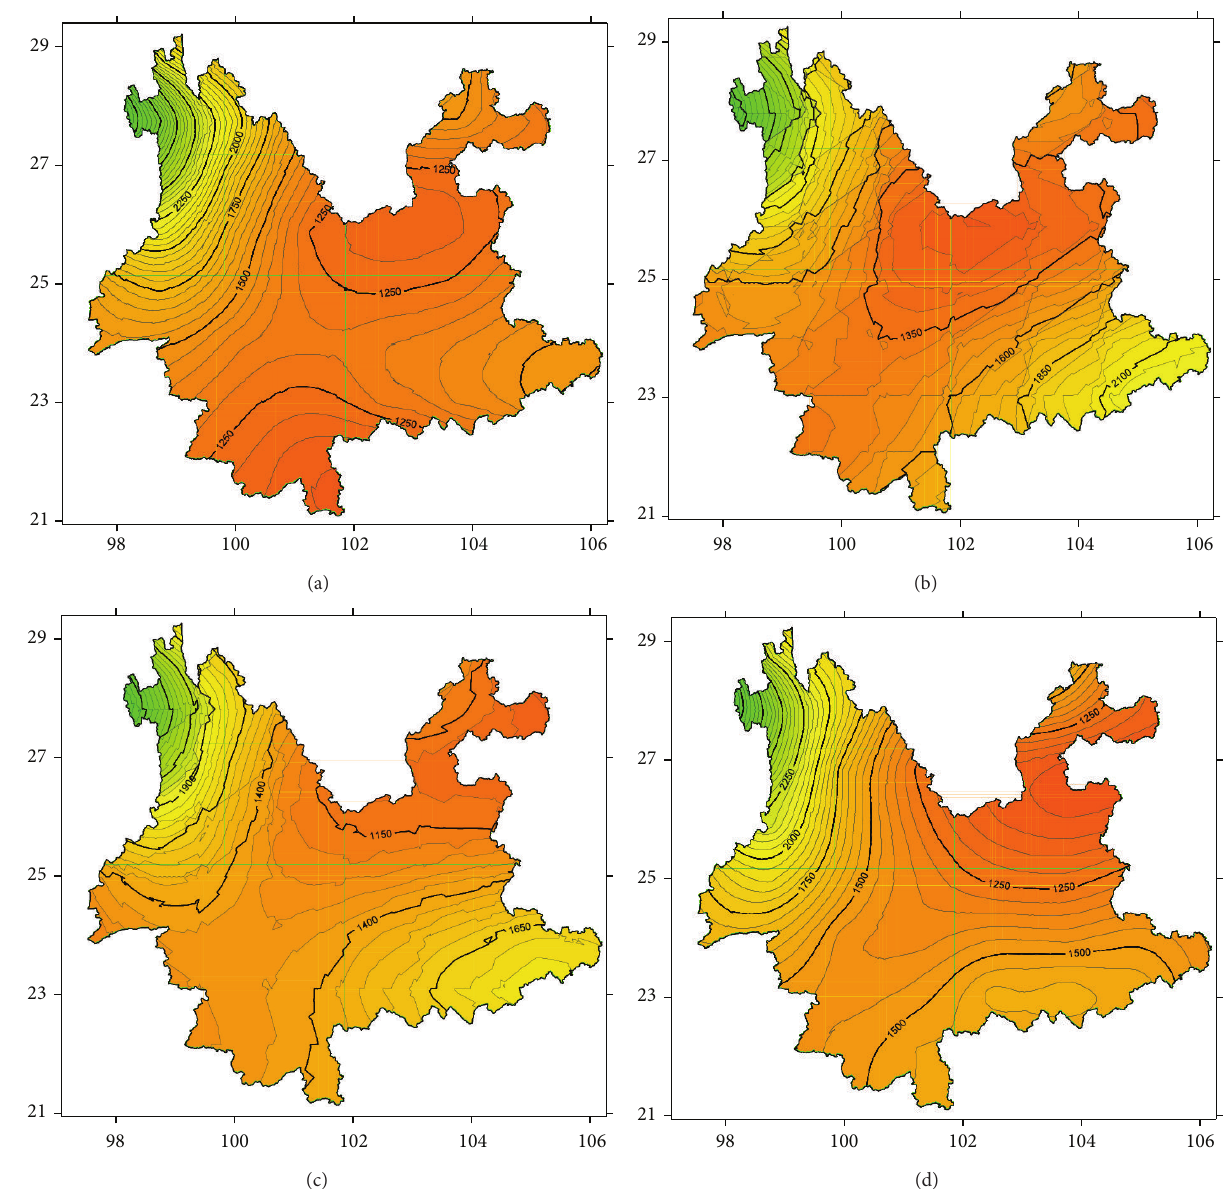
Figure 6: Spatial heterogeneity of precipitation in Yunnan province during 2020–2050 (unit: mm): (a) 2020; (b) 2030; (c) 2040; (d) 2050.